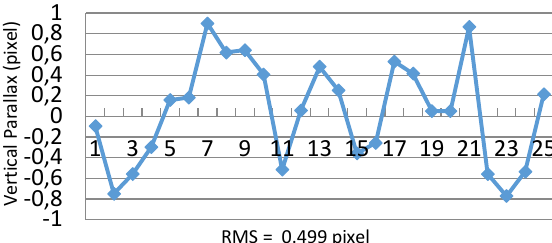
Figure 6. Distance between conjugate points and the quasi- epipolar line of 2nd stereo image pair